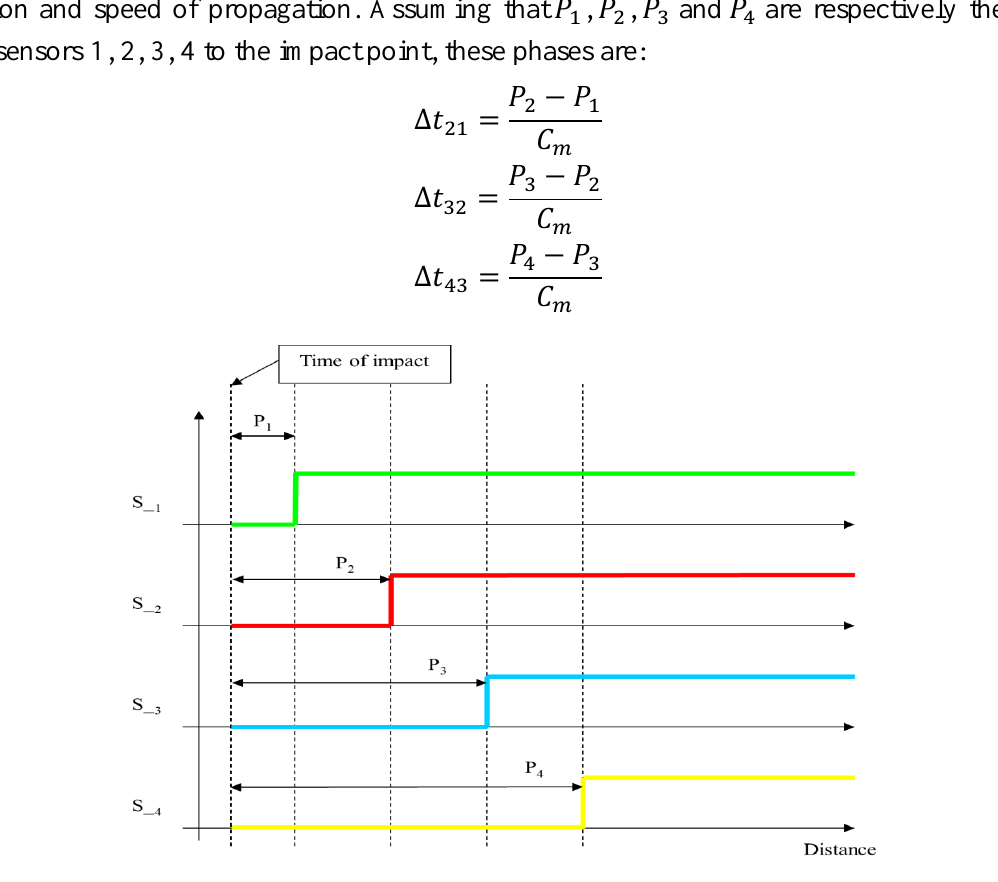
Figure 3. Time of impact on a single bar between sensors 1 and